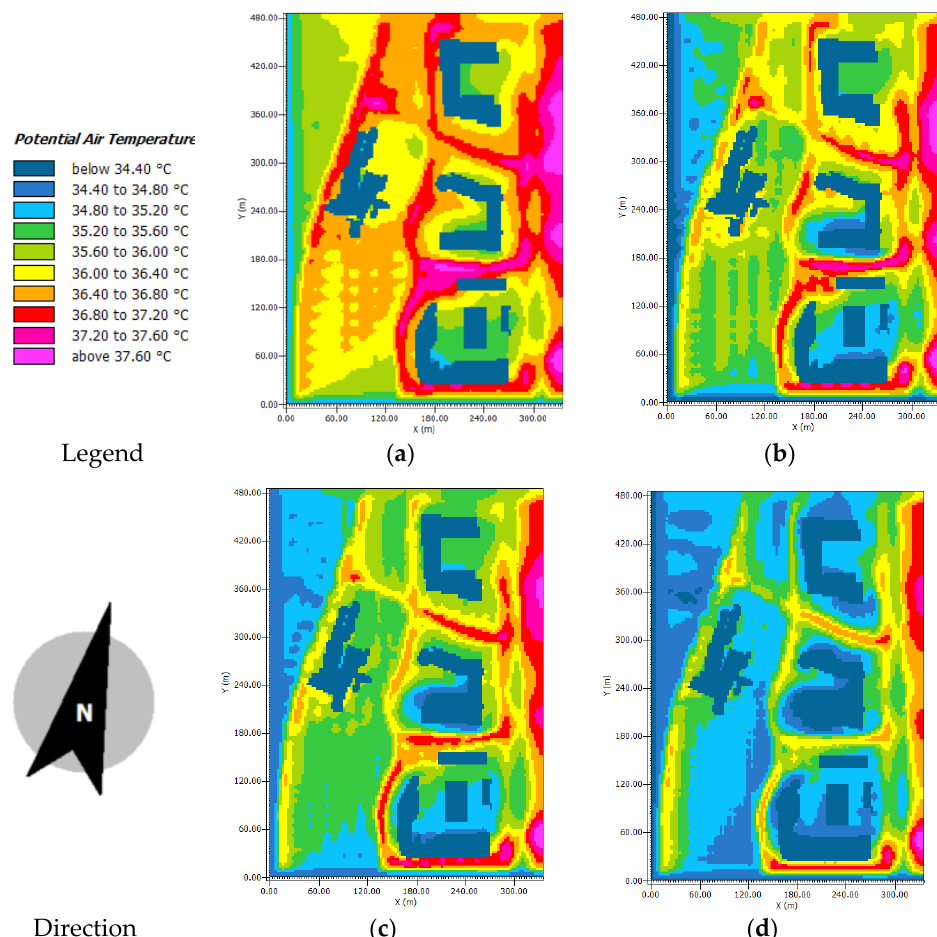
Figure 10. Comparison of simulated T a obtained at the height of 1.5 m at 15:00 for different greening rates. ( a ) Base case (A0); ( b ) Greening rate: 25% (A1); ( c ) Greening rate: 35% (A2); ( d ) Greening rate: 35% (A3).